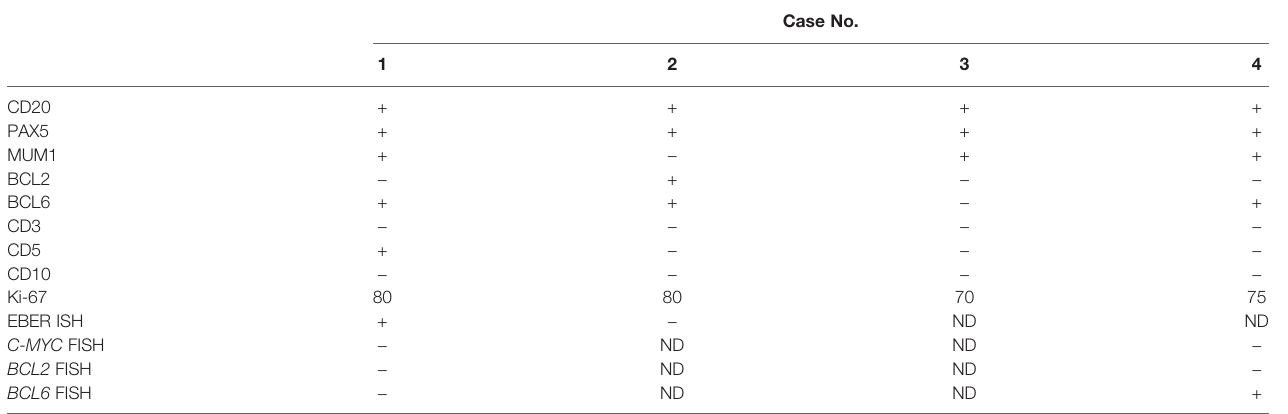
TABLE 2 | Immunohistochemistry, ISH, and FISH studies of the four cases of IVLBCL.